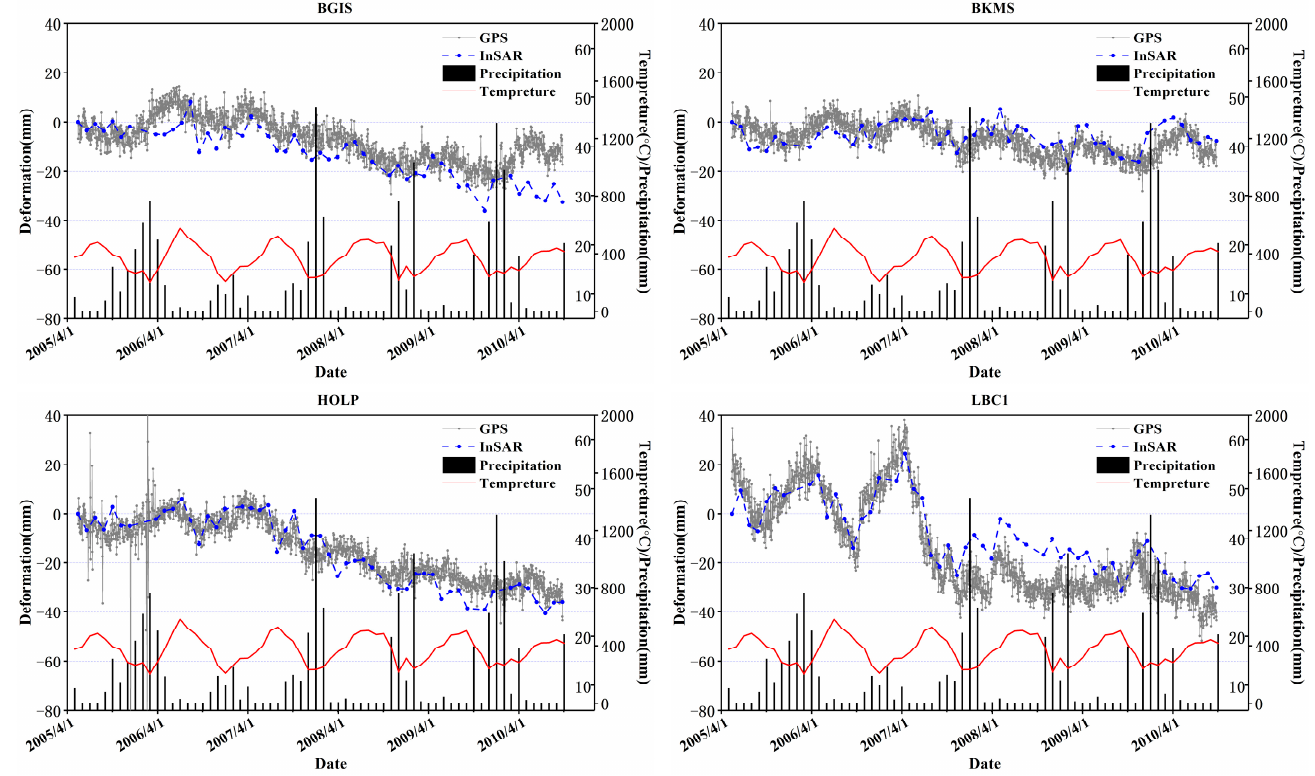
Figure 7. Time series deformation of GPS and InSAR monitoring results. Gray points connected by the gray solid line represent the GPS observation data projected on LOS direction of track 170 ASAR dataset. Blue points connected by the blue dashed line display time-series measurements of InSAR monitoring results. Grey bar chart illustrates the monthly cumulative precipitation. Red solid line illustrates the monthly temperature.